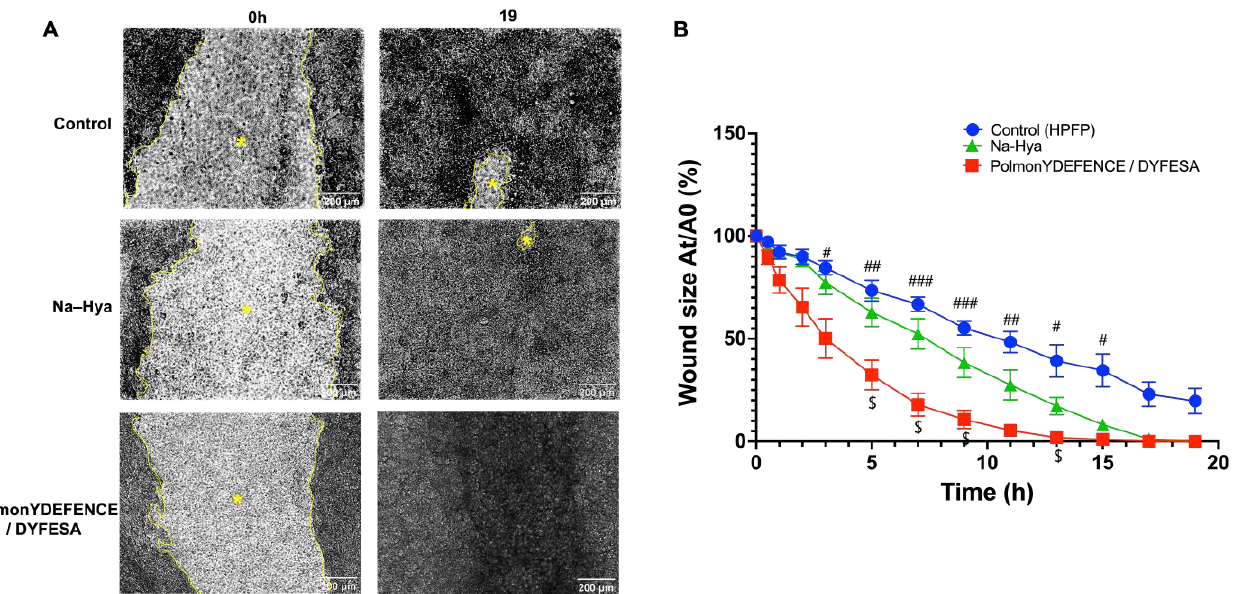
Figure 4. Wound healing study for PolmonYDEFENCE/DYFESA on Calu-3 epithelium in Transwells. ( A ) Time-lapse microscopy images comparing wounds at 0 h and 19 h with the brighter area outlined in yellow (*) representing the wound. ( B ) Graphical representation of the percentage of wound size of Area nt/Area 0t across a time course of 19 h to represent wound closure. Statistical significance was calculated using a two-way ANOVA with Tukey’s multiple comparisons test. Where the symbol (#) denotes significant differences between Control and PolmonYDEFENCE /DYFESA TM (# p < 0.033; ## p < 0.0021; ### p < 0.0002) and the symbol ($) denotes significant differences between Sodium hyaluronate and PolmonYDEFENCE /DYFESA TM ($ p <